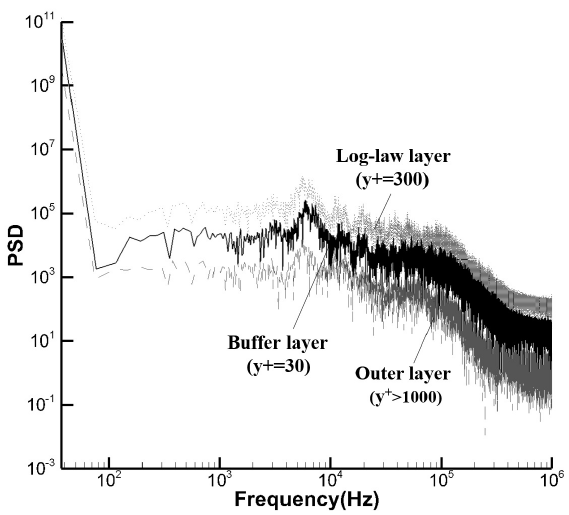
Figure 9. PSD at positions